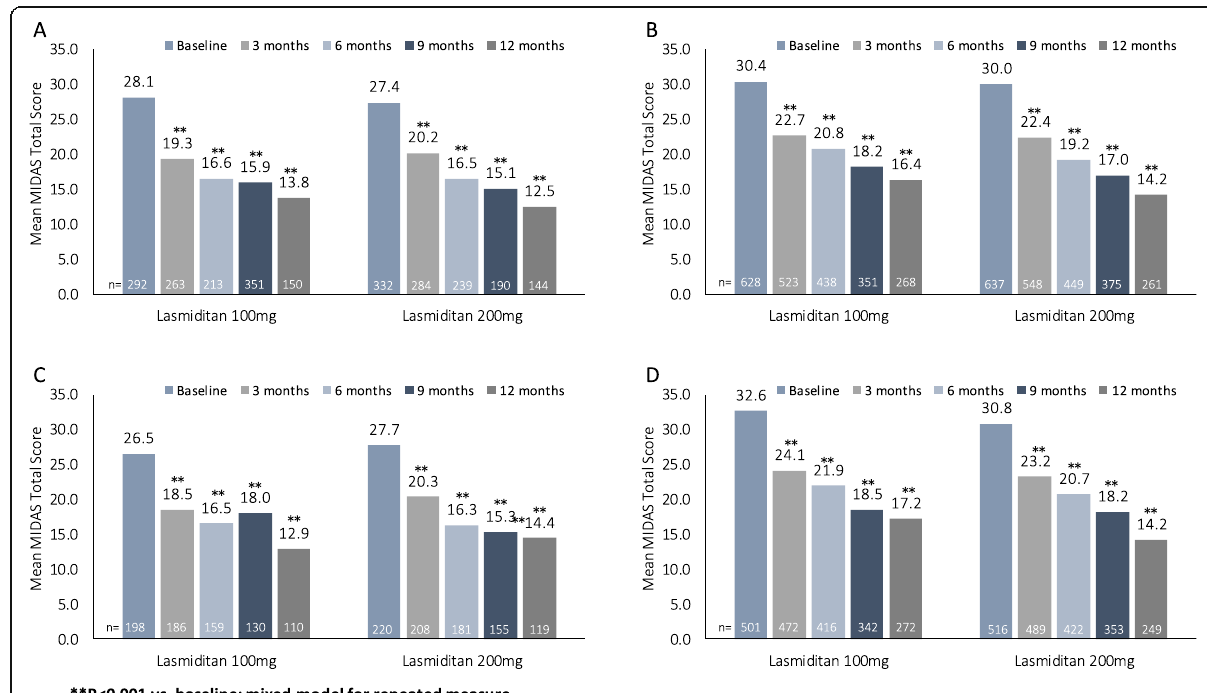
Fig. 5 Mean MIDAS Score by pain-free response 2 h post-dose ( a ) yes, first attempt, ( b ) no, first attempt, ( c ) yes, ≥ 2 of first 3 attempts ( d ) no, ≥ 2 of first 3 attempts (intent-to-treat population). **P < 0.001 vs. baseline; mixed model for repeated measures There were no significant differences between the lasmiditan